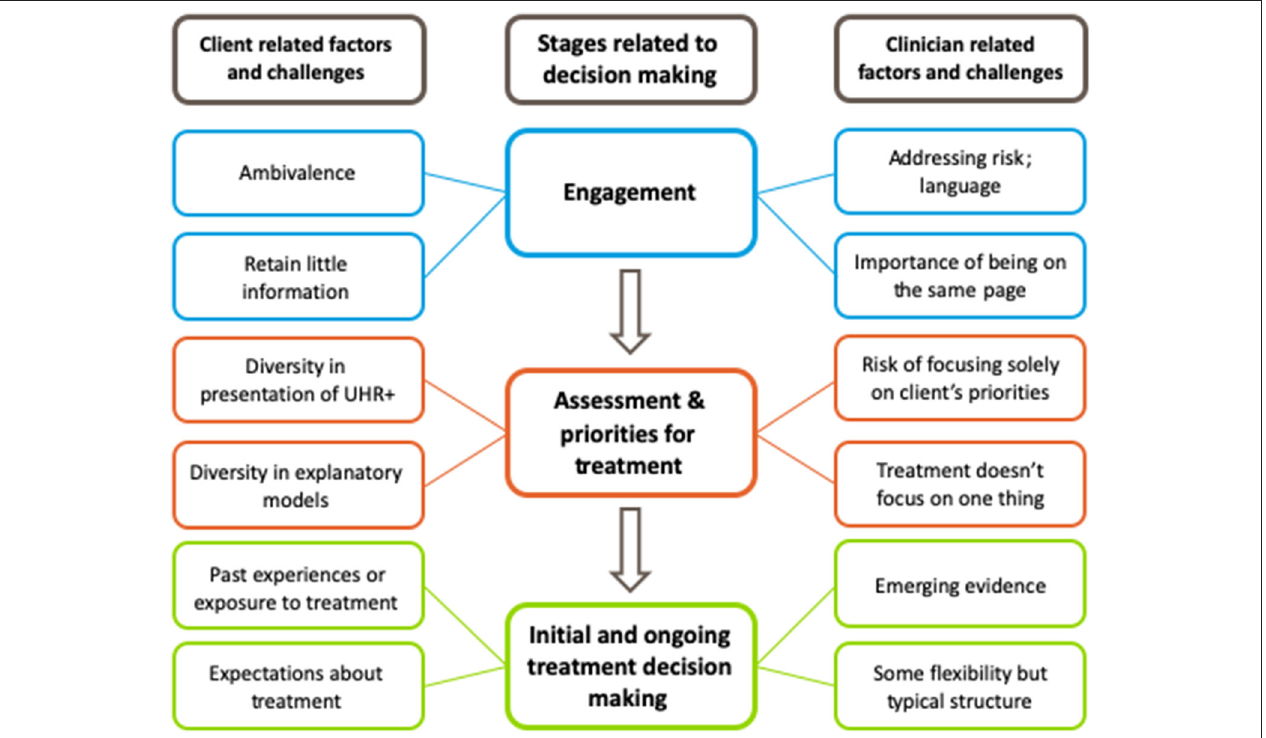
FIGURE 1 | Thematic map of clinician reported experiences and beliefs about treatment decision making for young people who meet the “Ultra High Risk” (UHR)